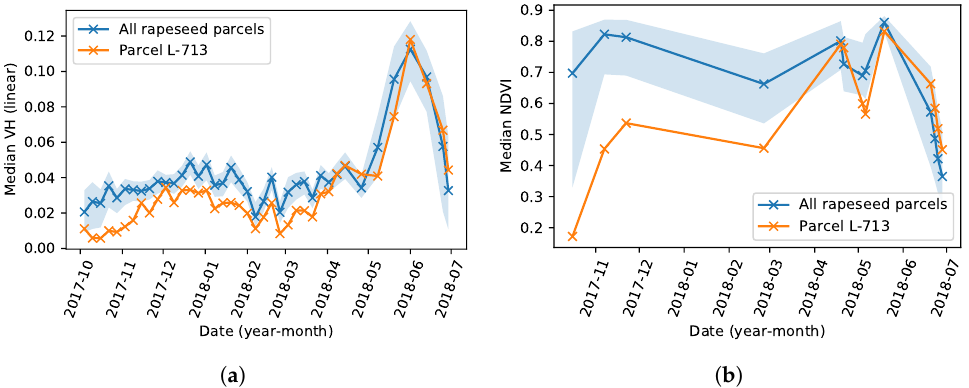
Figure 8. Examples of time series subjected to late growth for a rapeseed parcel: ( a ) median VH and ( b ) median NDVI for a rapeseed parcel. The blue line is the median value of the whole dataset. The blue area is filled between the 10th and 90th percentiles. The orange line corresponds to a specific parcel subjected to late